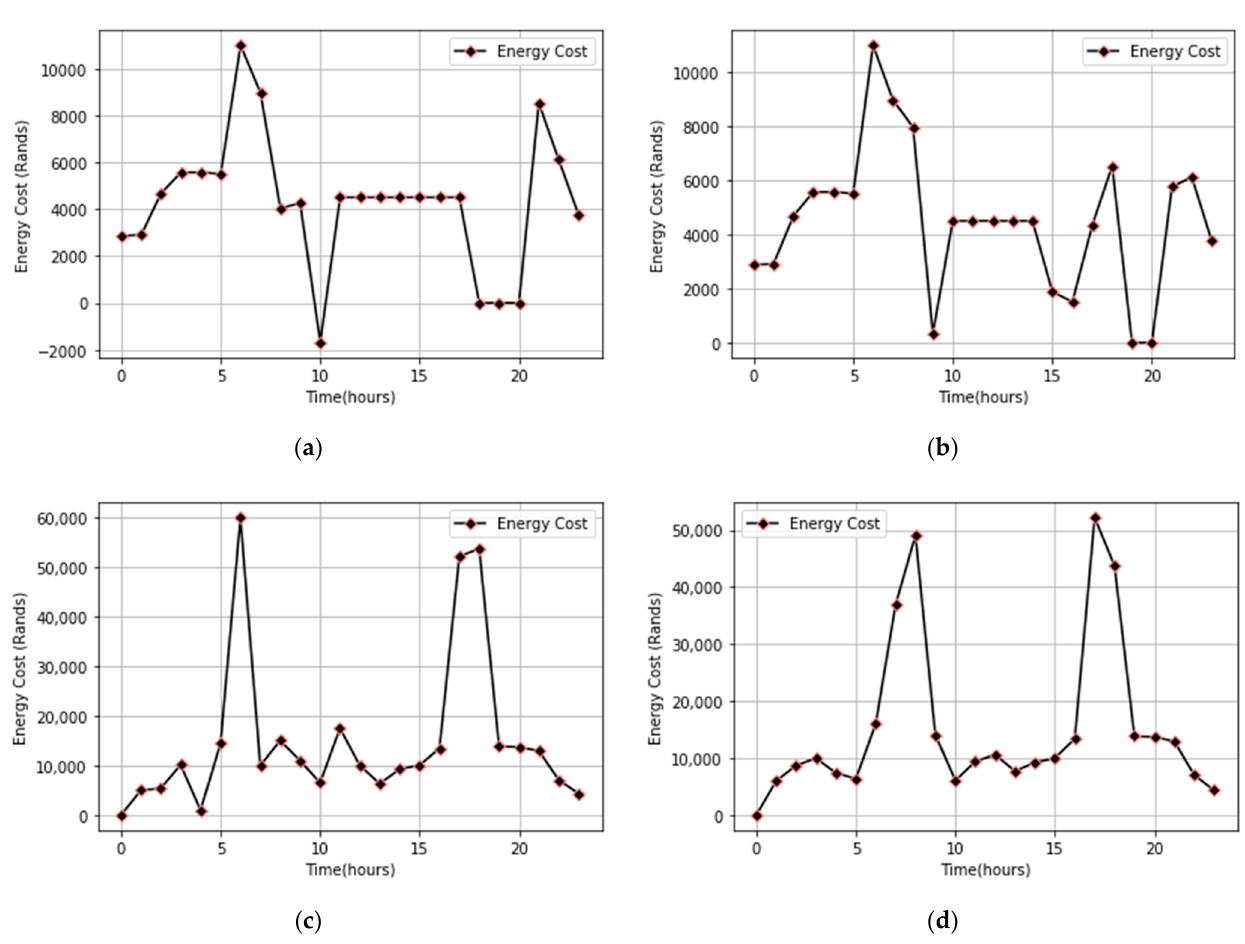
Figure 11. Cost profiles for the optimized schedule; ( a ) Summer dispatching cost profile for the optimized schedule (trading algorithm) ( b ) Summer dispatching cost profile for the optimized schedule (non-trading algorithm) ( c ) Winter dispatching cost profile for the optimized schedule (trading algorithm) ( d ) Winter dispatching cost profile for the optimized schedule (non-trading algorithm).